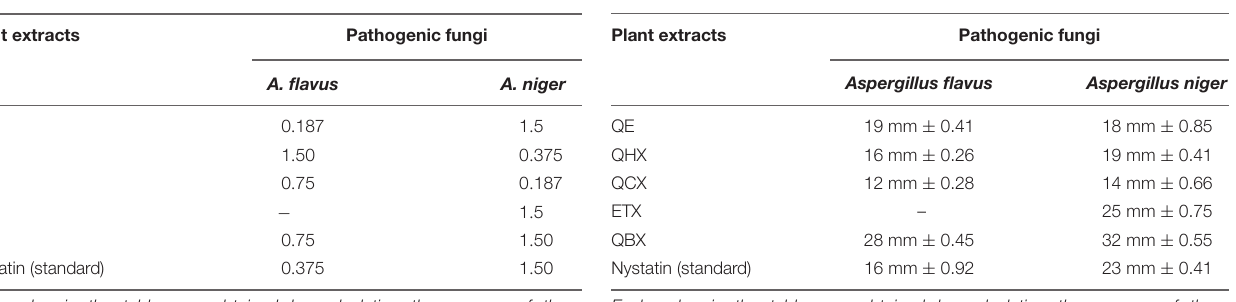
TABLE 6 | Antifungal activity of Q. incana Roxb. (3 mg/ml, zone of inhibition in mm ± SD